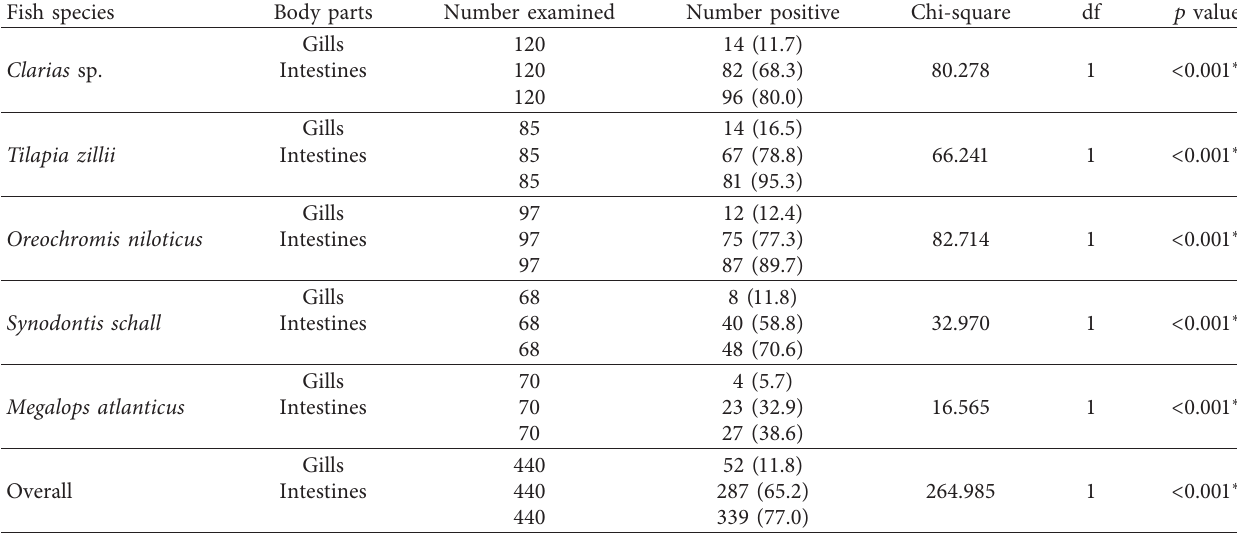
Table 5: Prevalence of parasites according to body parts of the fish species.